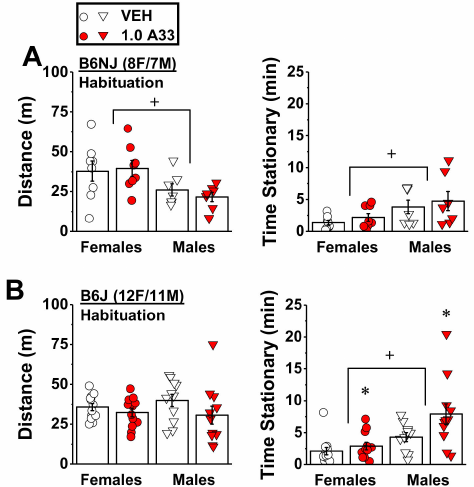
Figure 6. Effect of A33 on spontaneous locomotor activity. Summary of the effects of immediate pretreatment with either vehicle (VEH) or 1.0 mg/kg of A33 (1.0 A33) on ( A ) the total distance traveled and the time spent stationary by female and male B6NJ mice during a 30 min test (8 females/7 males). ( B ) Same as Panel A for female and male B6J mice (12 females/11 males). The data represent the mean ± SEM of the number of mice indicated, in addition to the individual data points for each experimental group. * p < 0.05 vs. 0 mg/kg of A33 (main effect); + p < 0.05 vs. females (main